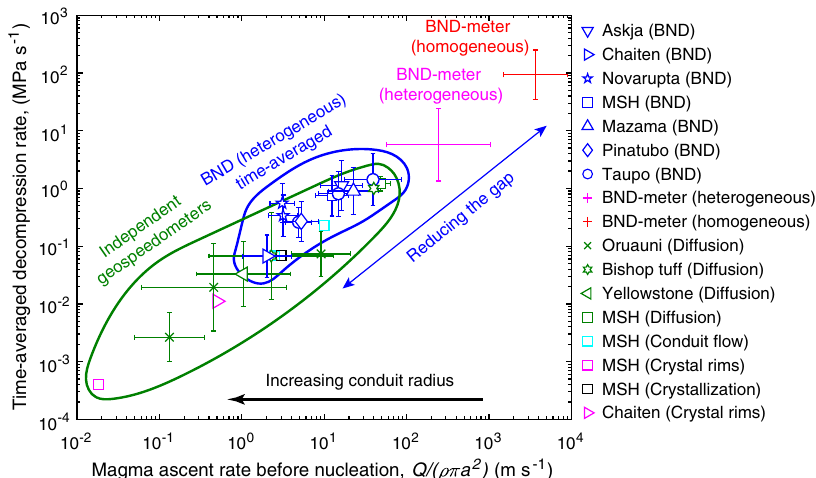
Fig. 3 Estimated decompression rates for silicic Plinian eruptions. The blue symbols show the time-averaged estimates from bubble number density with heterogeneous nucleation on magnetite. The error bars represent uncertainties in magnetite contact angle. Heterogeneous nucleation substantially reduces the gap in decompression rate between homogeneous nucleation and independent geospeedometers that include: diffusion in melt inclusions and melt embayments for May 18th, 1980 Mt. St. Helens 60 , 0.77 Ma Bishop tuff 65,66 , 27 ka Oruauni 66 – 68 , and 2 Ma Yellowstone 66 ; conduit models for May 18th, 1980 Mt. St. Helens 61,62 ; crystal rims for May 18th, 1980 Mt. St. Helens 63 and 2008 Chaiten 43 ; and groundmass crystallization for May 18th, 1980 Mt. St. Helens 64 .